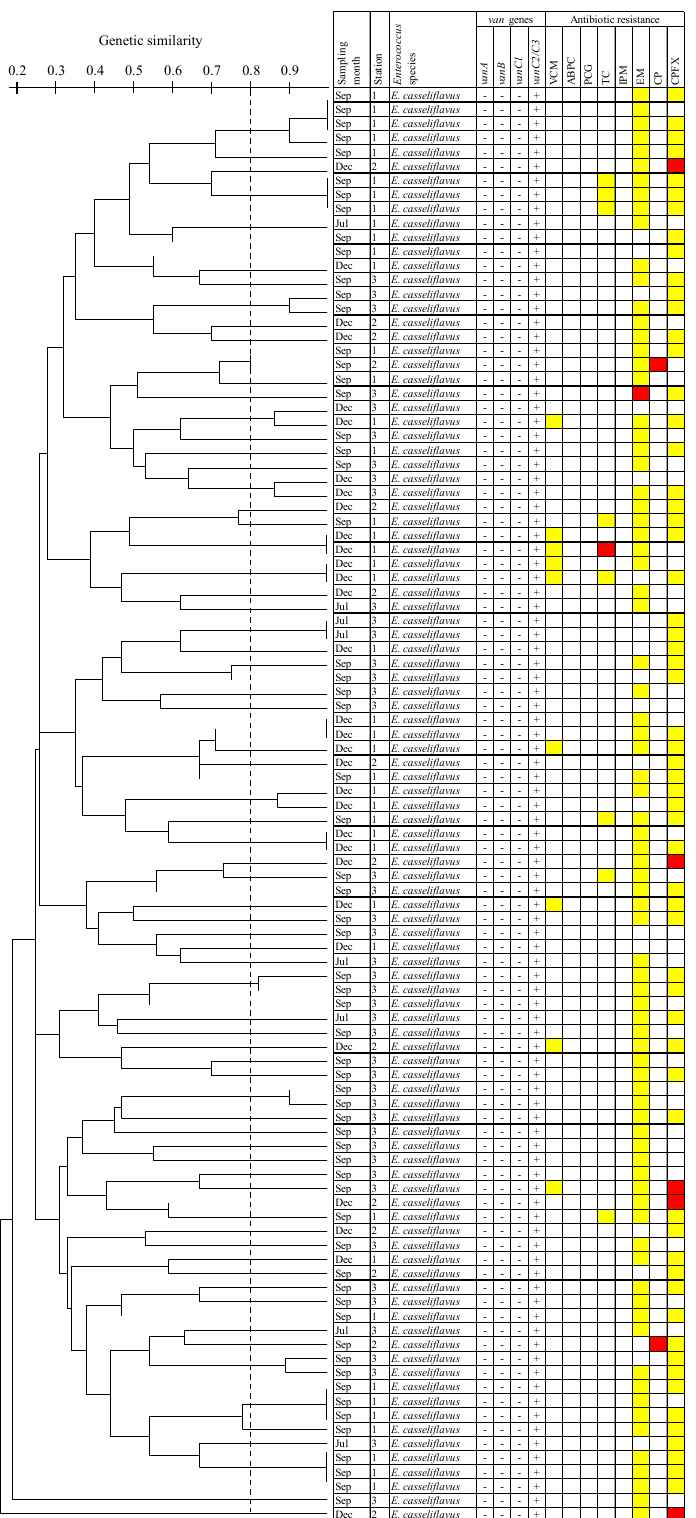
Figure 4. Dendrograms of pulsed-field gel electrophoresis types and antibiotic resistance profiles for E. casseliflavus isolates from each sampling site in Yae River. Concerning antibiotic resistance phenotypes, red indicates resistance, yellow indicates intermediate resistance, and white indicates susceptibility. VCM, Vancomycin; ABPC, Ampicillin; PCG, Penicillin G; TC, Tetracycline; IPM, Imipenem; EM, Erythromycin; CP, Chloramphenicol; CPFX, Ciprofloxacin; +, Positive; − , Negative.